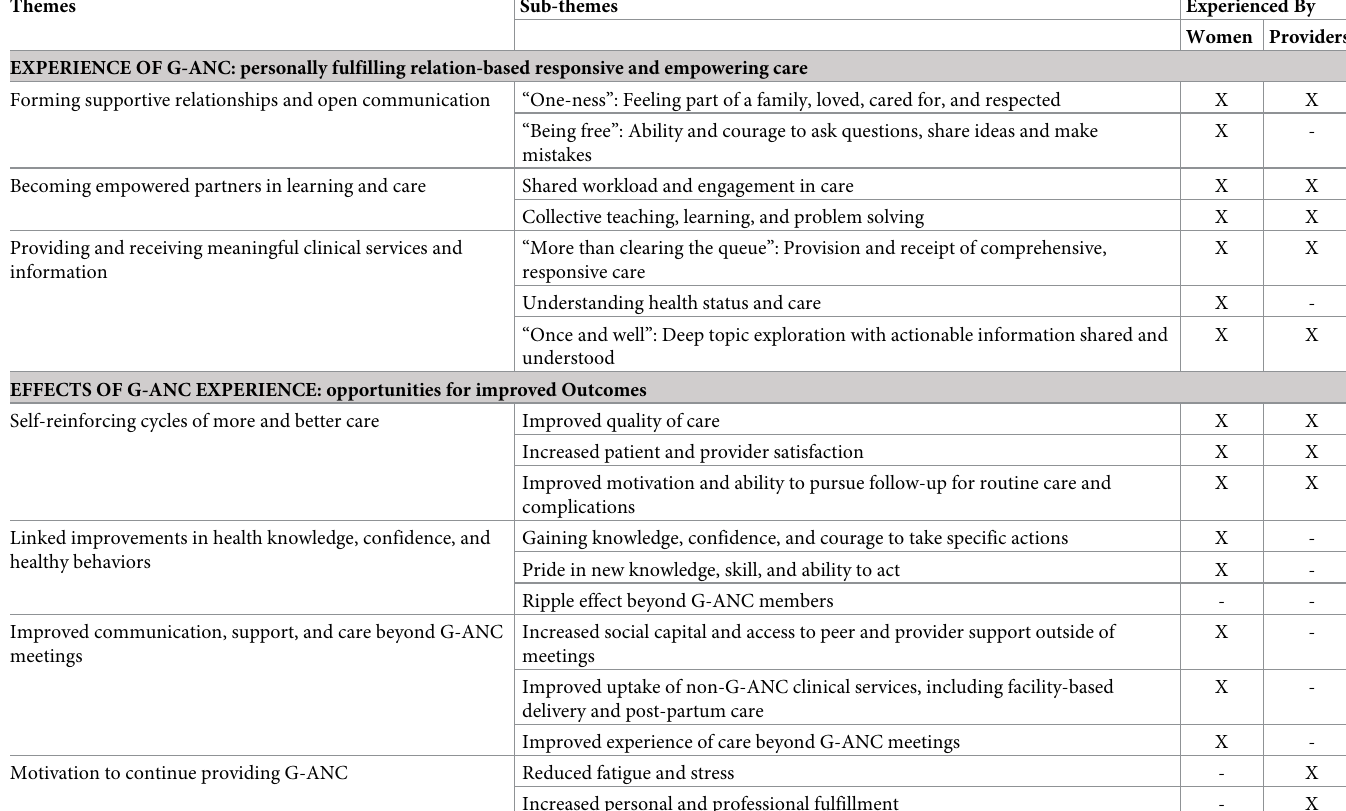
Table 3. Themes related to the experience and effects of G-ANC by women and